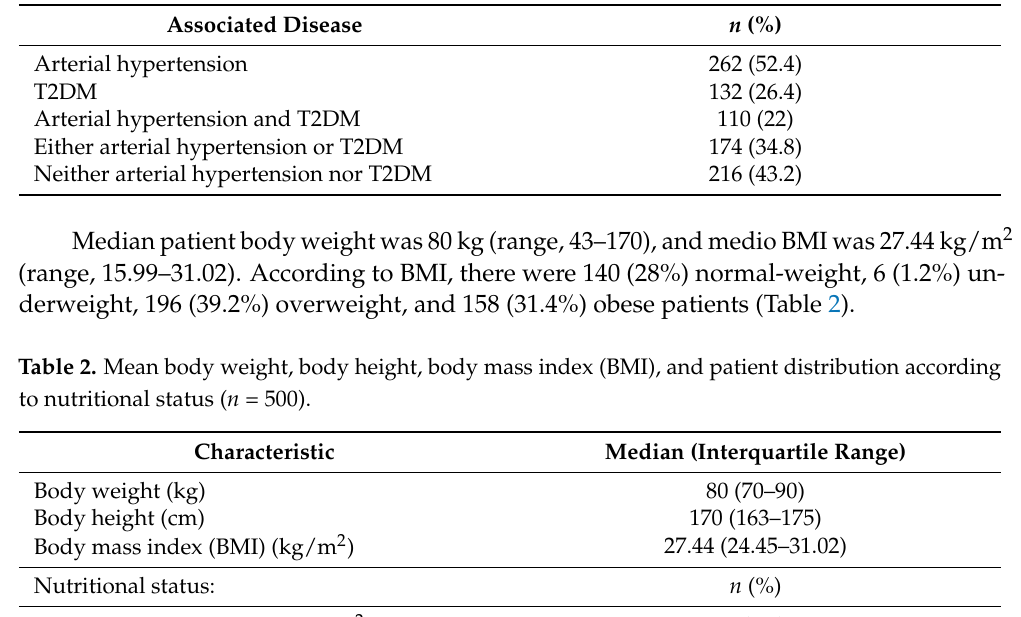
Table 1. Patient distribution according to associated diseases ( n = 500).